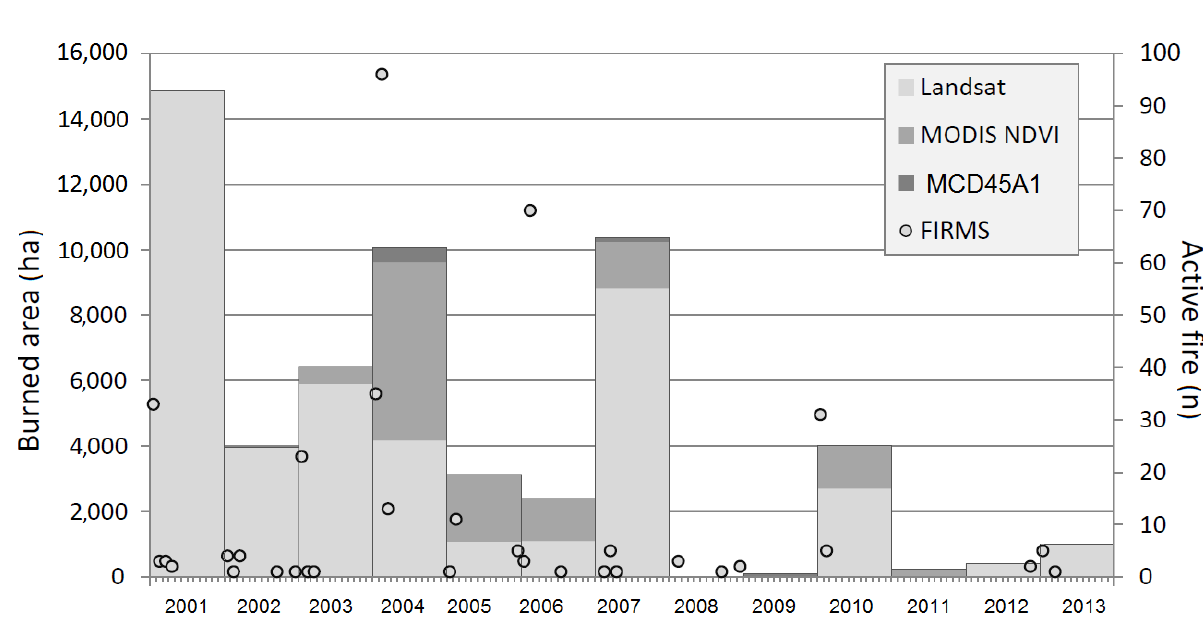
Figure 5. Descriptive statistics of the detected burned areas and FIRMS [44] active